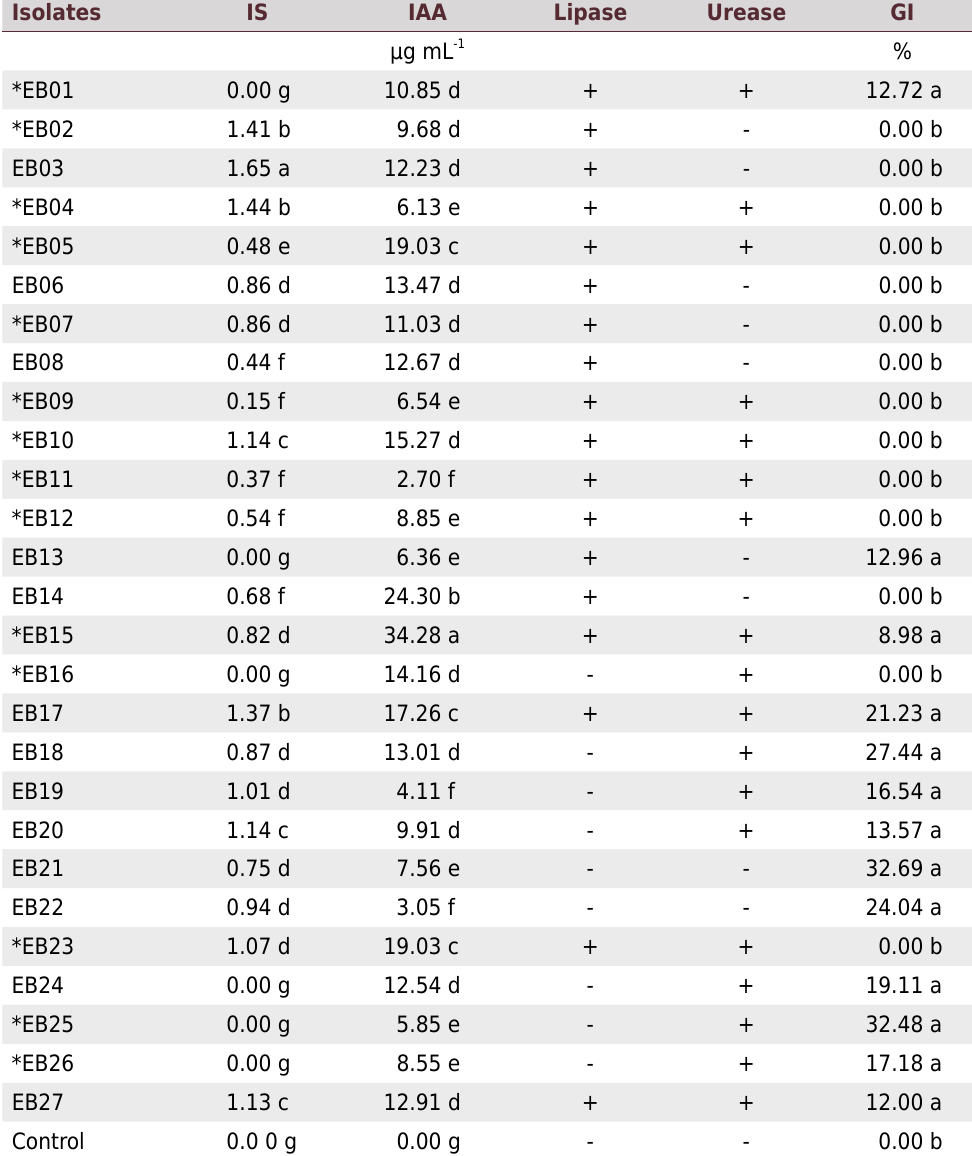
Table 4. Plant-growth promoting mechanisms of Bacillus isolates Isolates IS IAA Lipase Urease